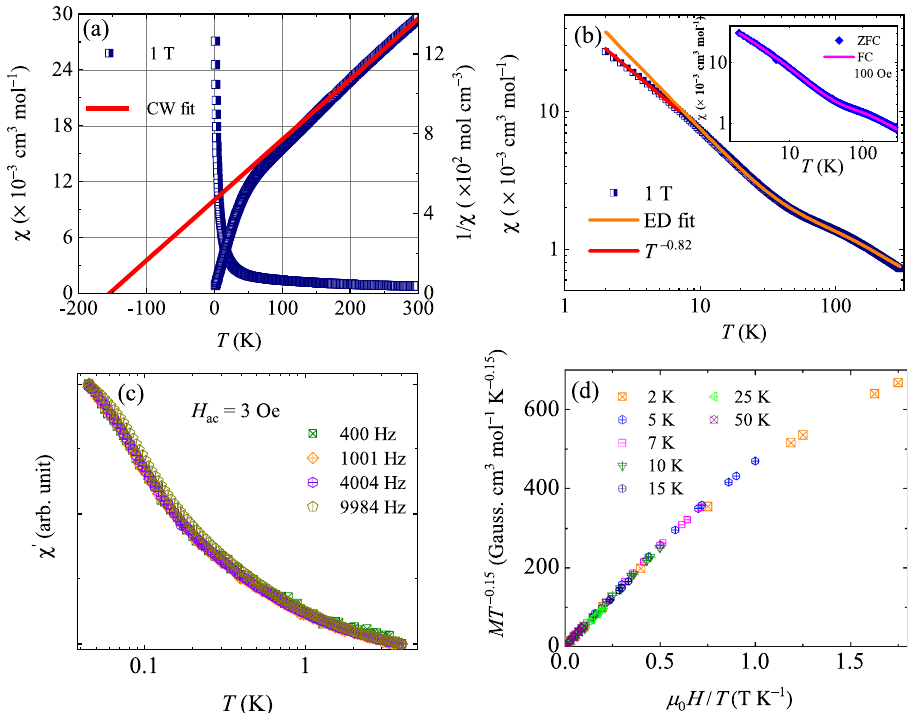
Fig. 2 Magnetization results of Li 4 CuTeO 6 . a The temperature dependence of the magnetic susceptibility (left y axis) and inverse magnetic susceptibility (right y axis) in a magnetic fi eld μ 0 H = 1 T. The solid red line represents the Curie – Weiss (CW) fi t. b The temperature dependence of magnetic susceptibility at 1 T with a high- T (high-temperature) fi t using exact diagonalization (ED) results, and a low T fi t using a power-law. The inset shows the zero- fi eld-cooled (ZFC) and fi led cooled (FC) susceptibility in a magnetic fi eld of 100 Oe. c The temperature dependence of the real part of ac susceptibility in different frequencies down to 45 mK. d Data collapse for MT − 0.15 , where M is the magnetization and T is the temperature, as a function of μ 0 H / T